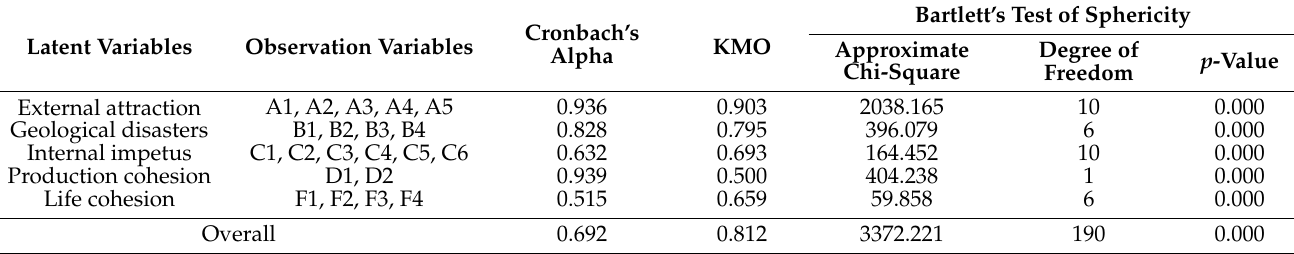
Table 3. Analysis of questionnaire reliability and validity.